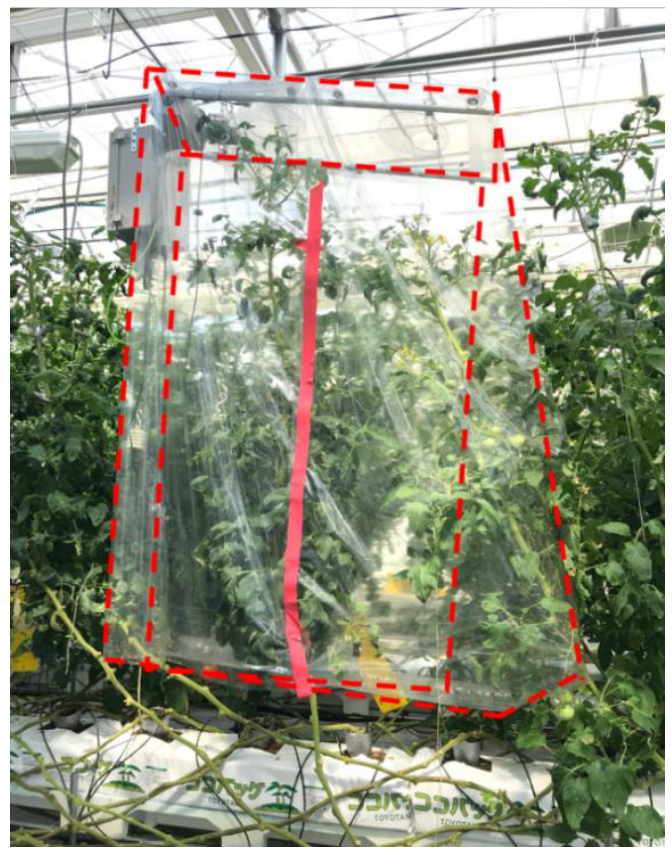
Figure 1. Chamber inside the greenhouse.